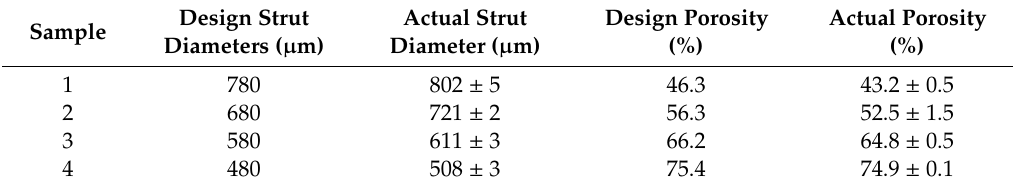
Table 2. Strut diameters and porosities of designed and manufactured porous